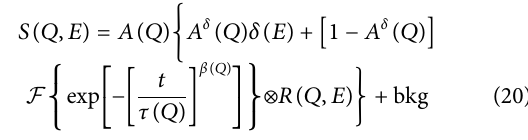
FIGURE5| Exemplary fi toftheQENSspectraofBCOatfouragingstagesusing Eq.20 .Thenormalized residuals( exp data − fit the quality of the fi